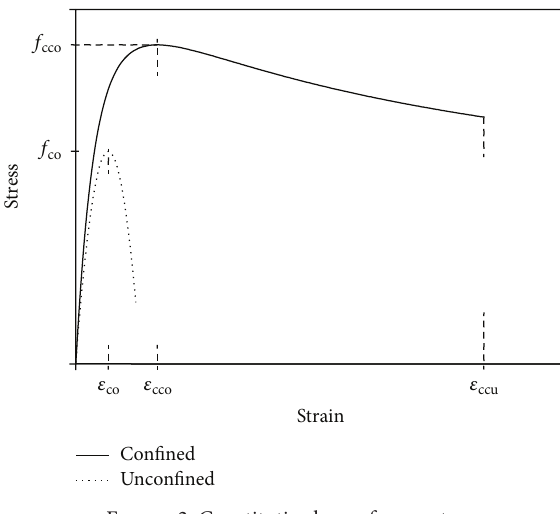
Figure 2: Constitutive laws of